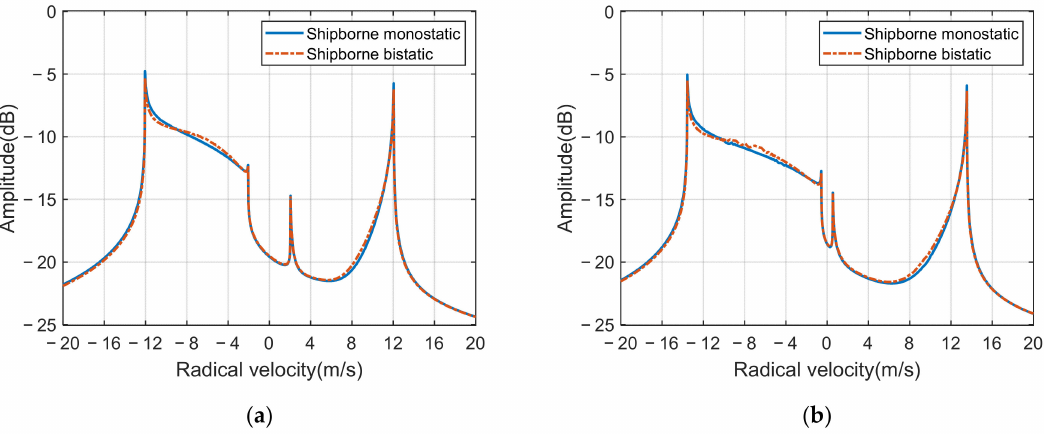
Figure 4. Simulated shipborne bistatic (red dotted line) and shipborne monostatic (blue solid line) first-order Doppler spectra for a detection range sum of 50 km. ( a ) The platforms’ speed is 5 m/s. ( b ) The platforms’ speed is 6.5